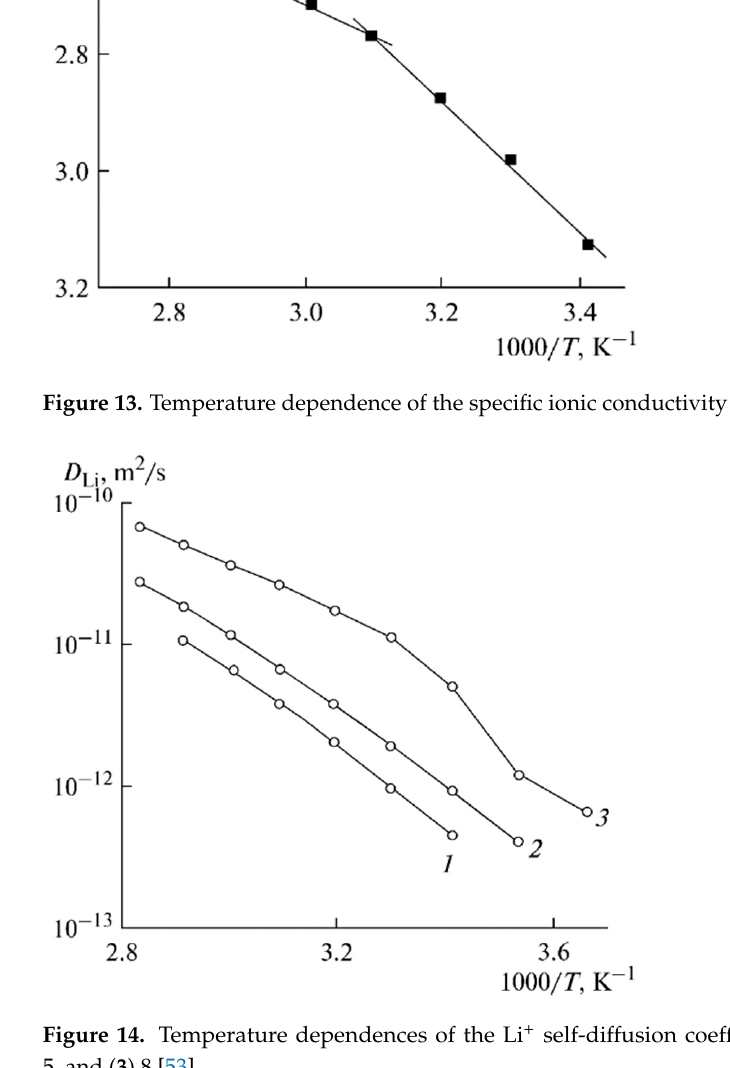
Table 5. Self-diffusion coefficients of lithium D Li , calculated conductivity σ NMR , activation energies